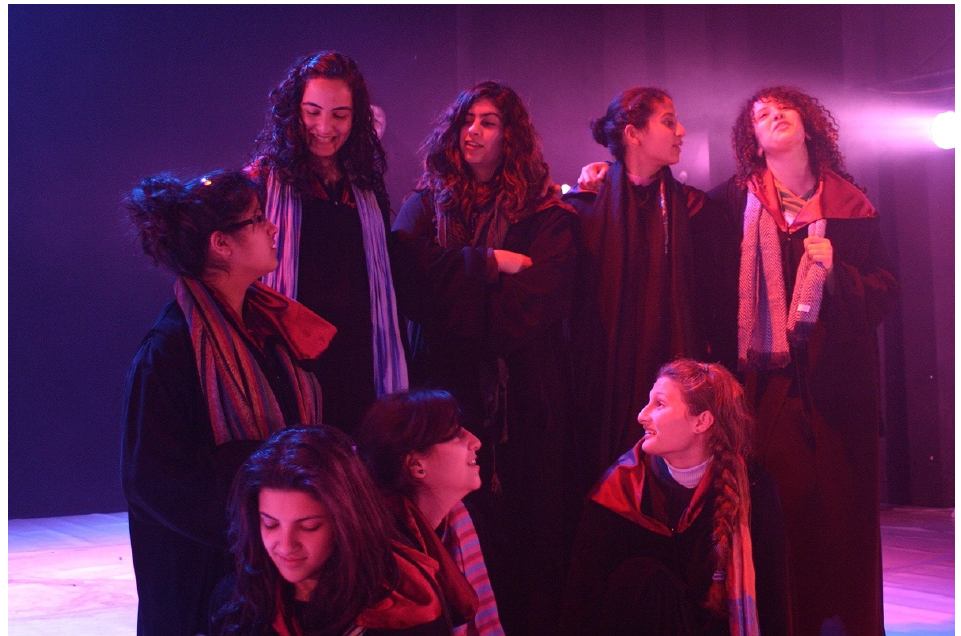
Figure 2. The chorus of Ophelia in El-Basha’s production. Photo: Akram Safadi. Courtesy of Kamel El-Basha and the Al-Hakawati Palestinian National Theatre.